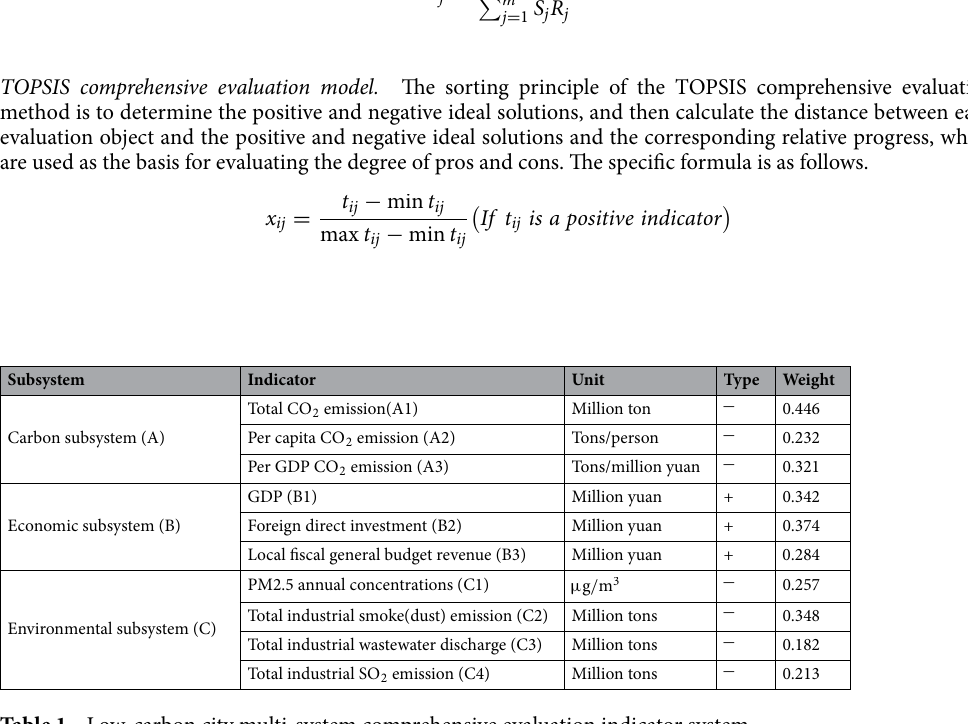
Table 1. Low-carbon city multi-system comprehensive evaluation indicator